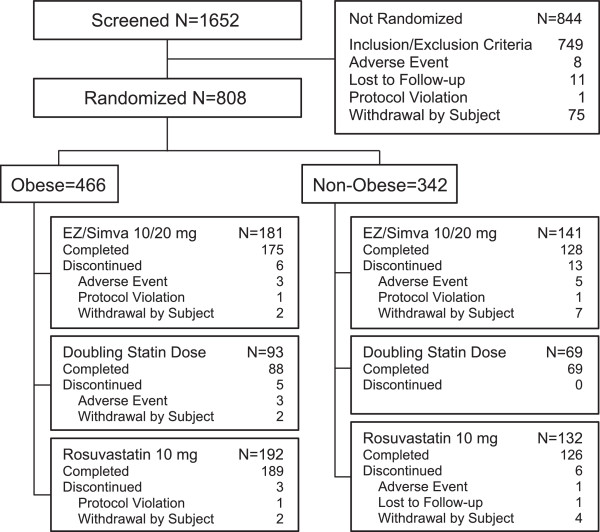
Flow of subjects through the study.